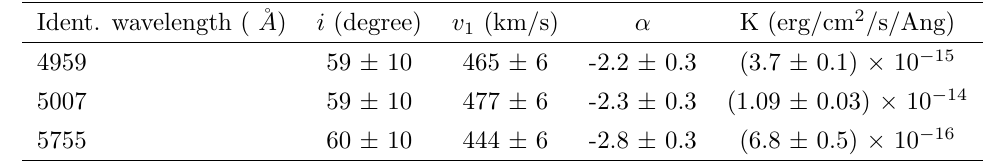
Table 1: Fit results of the line profiles of [OIII] 4959, 5007 and [NII] 5755, using the approach developed in [9]. Ident. wavelength ( ˚ A